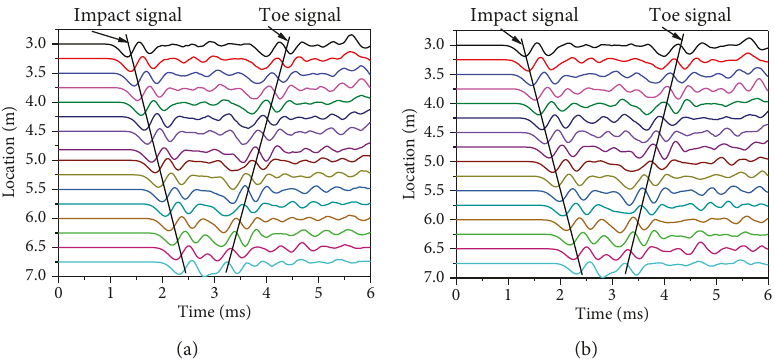
Figure 14: Raw velocity data. (a) Velocity data at A